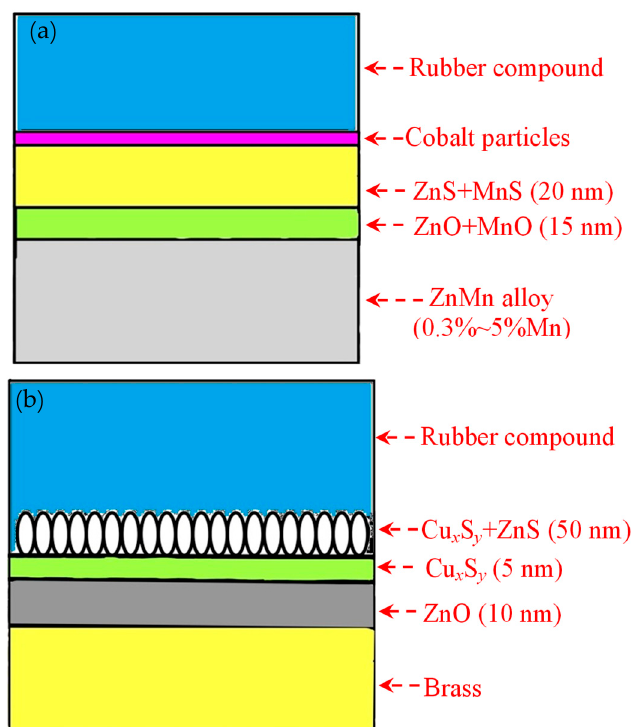
Figure 24. Schematic diagrams showing the adhesion mechanism between steel wire coating and rubber compound: ( a ) Cu-Zn alloy coating and ( b ) Zn-Mn alloy coating. Reprinted with permission from ref. [54].